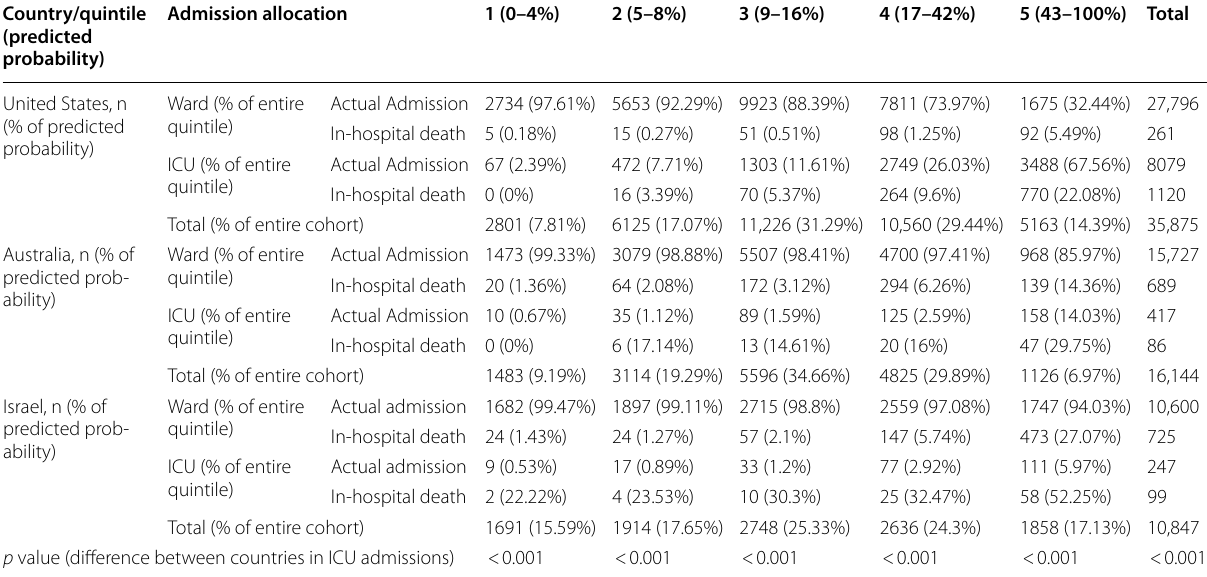
Quintiles represent predicted probabilities for admission in an intensive care unit according to the American cohort (see Table 2)